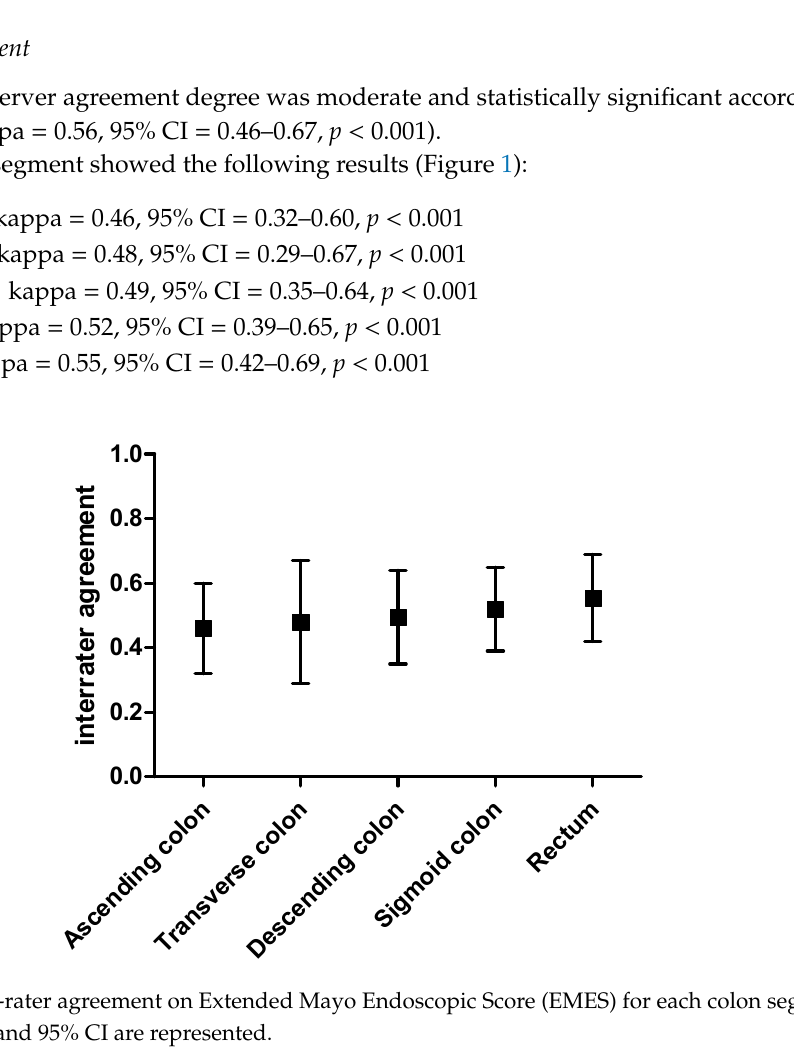
Table 1. Inter-observer agreement on EMES for each parameter of each colonic segment. Parameters